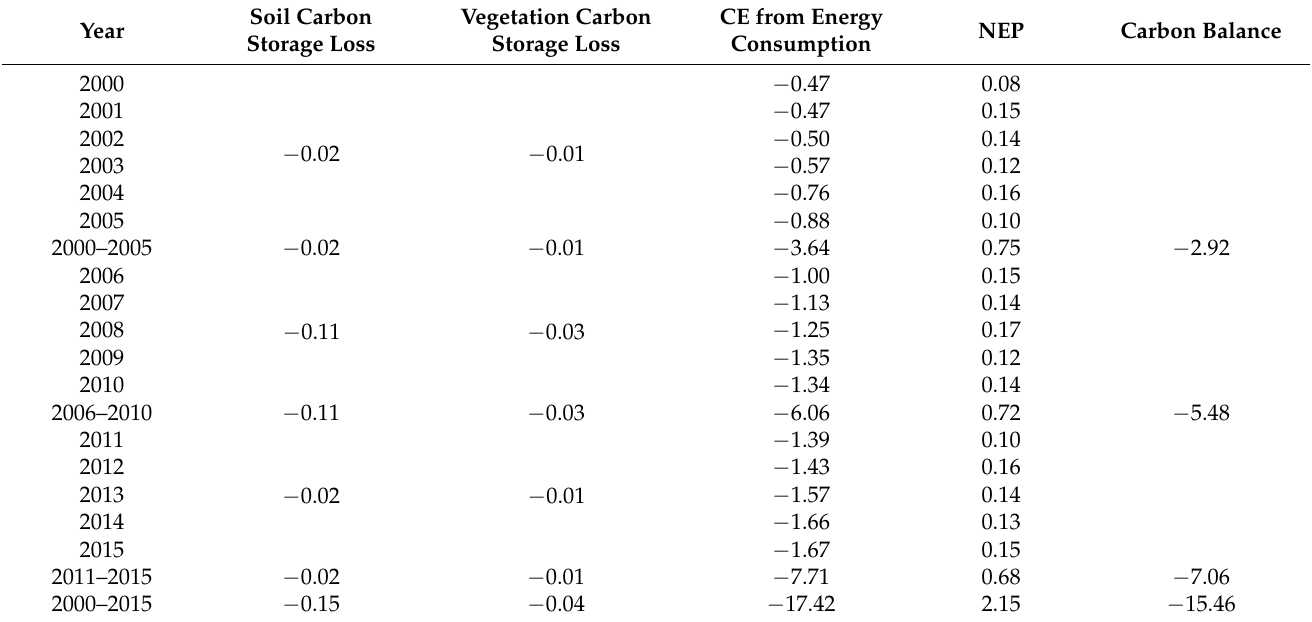
Table 5. Carbon balance change in 2000–2015 (10 4